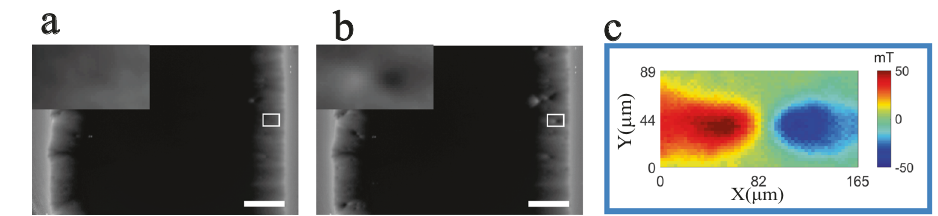
Fig. 3 Local fl ux patterns and distribution of their magnetic fi eld difference. a , b Flux patterns with tensile strains of 0.70% and 0.72% under zero- fi eld- cooled conditions at 64 mT and 40 K, respectively. The magni fi ed images of the white boxes are inserted in the top left corner, and the scale bar represents 500 μ m. c Their differential magnetic fi eld distribution.